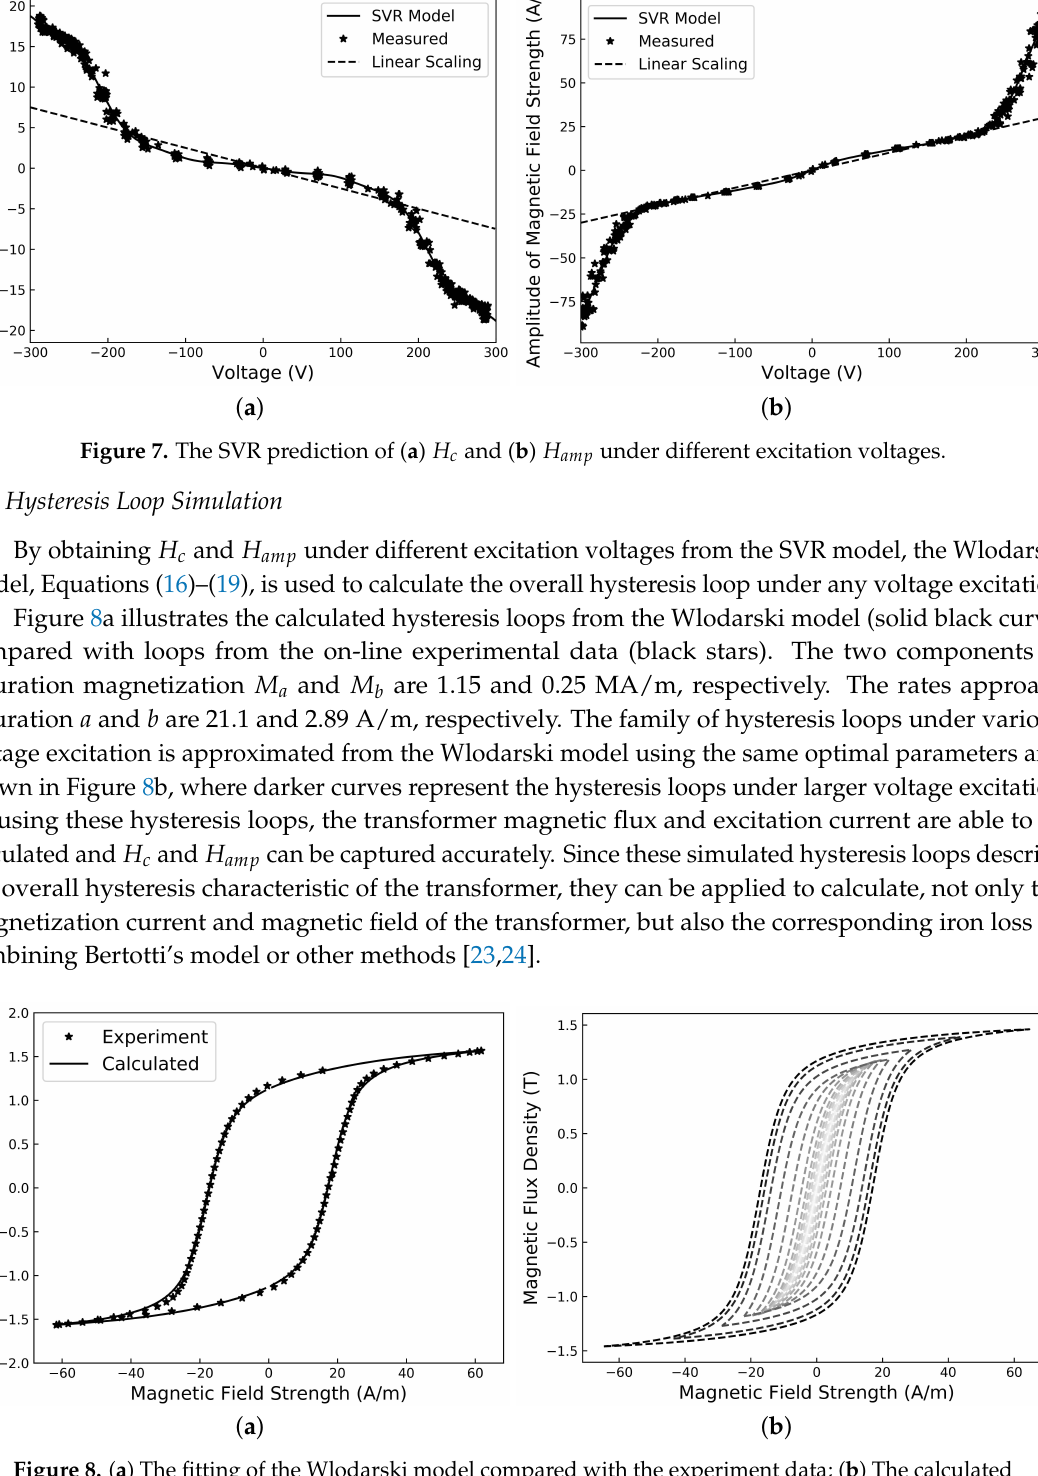
Figure 8. ( a ) The fitting of the Wlodarski model compared with the experiment data; ( b ) The calculated hysteresis loops from Wlodarski model with darker curve represents the hysteresis loop under larger voltage